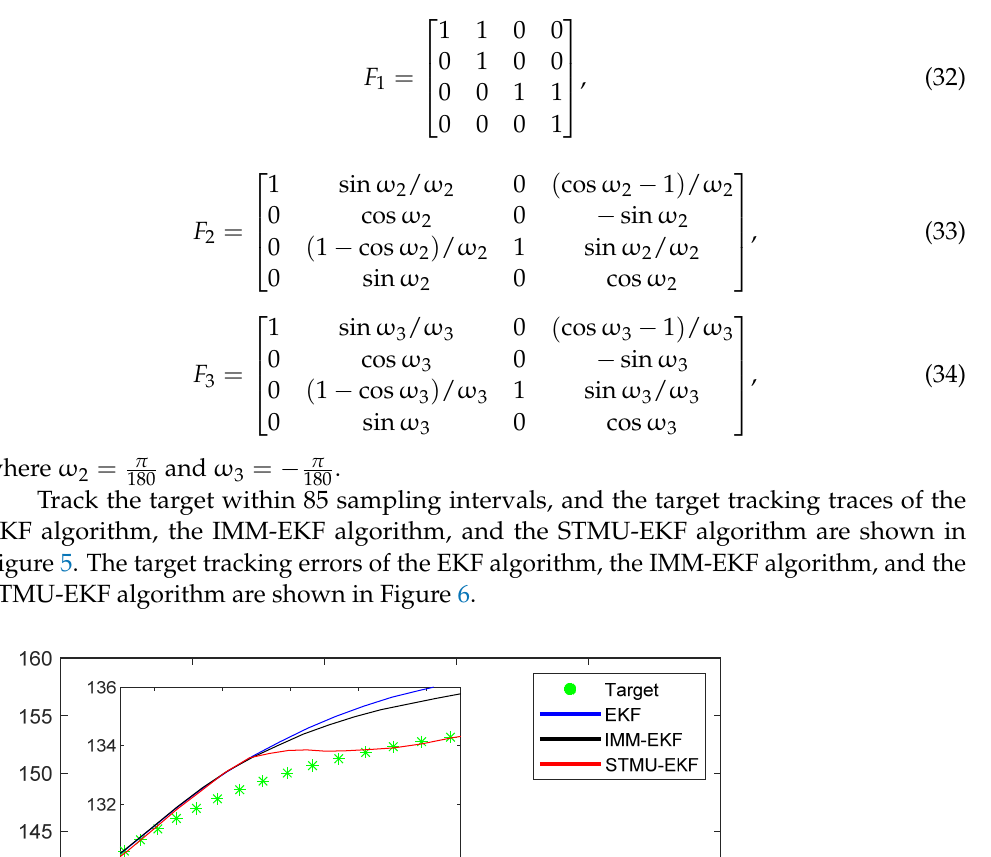
Figure 6. The target tracking error of the three passive target tracking algorithms.